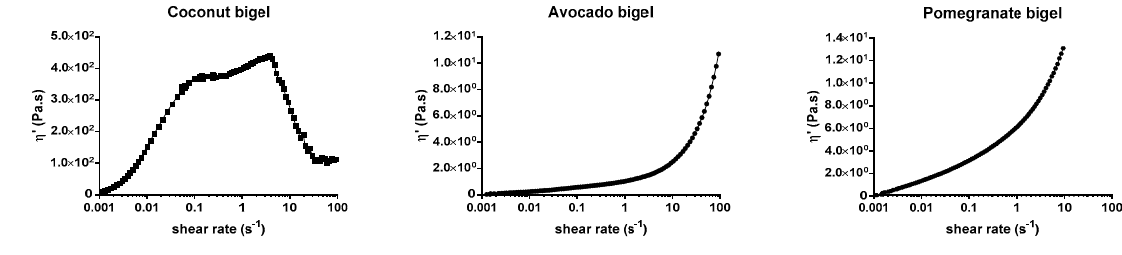
Figure 4. Viscosity curves of bigels vs. shear rate.